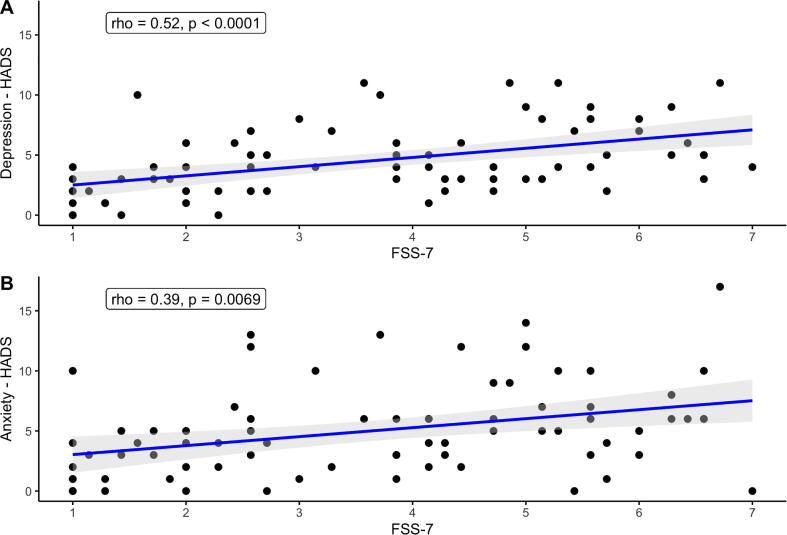
Associations between fatigue as measured by the Fatigue Severity Scale (FSS-7) and (A) depression and (B) anxiety.